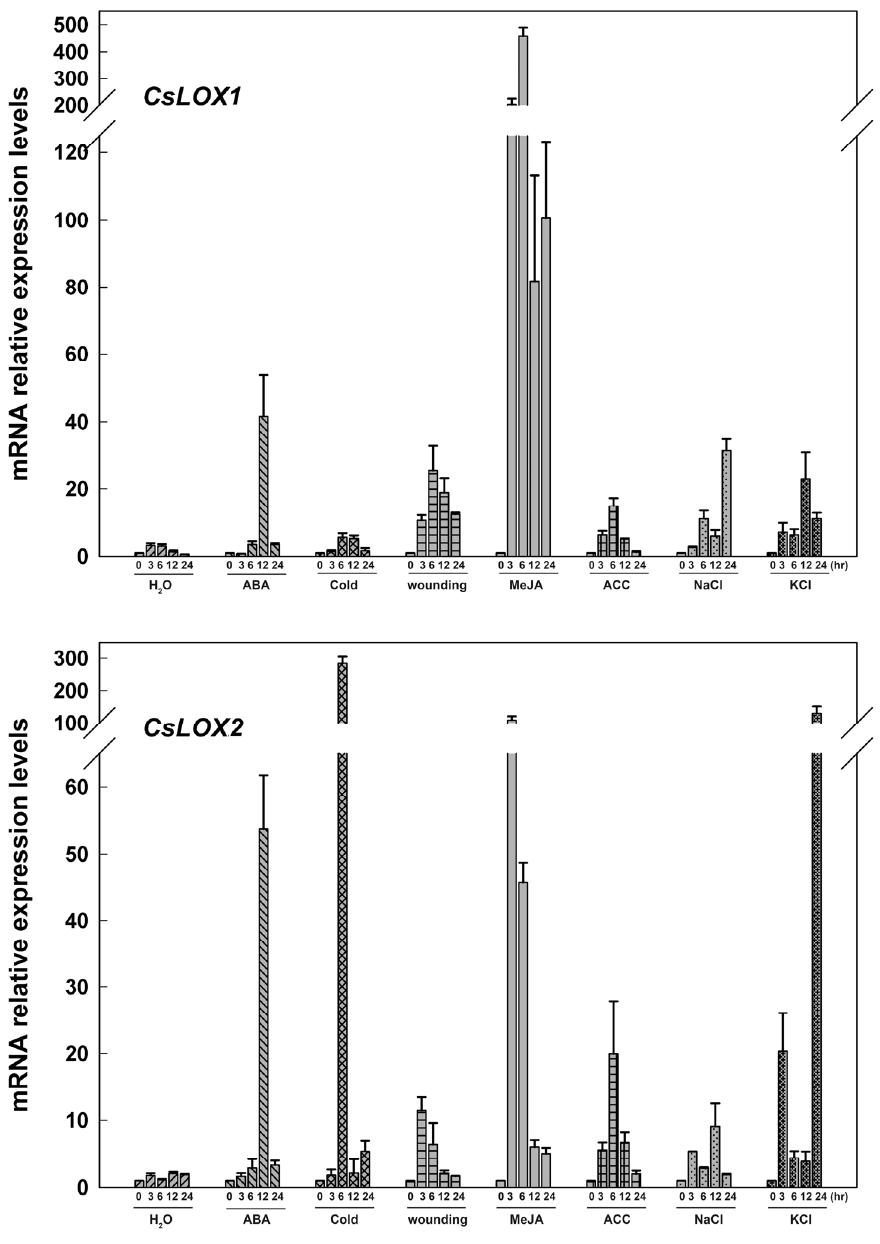
Figure 4. Expressions of CsLOX1 and CsLOX2 in cucumber leaves at various time points O, ABA (100 μ M), cold (4 °C), wounding, MeJA (100 μ M), ACC under treatments with H 2 (100 μ M) NaCl (200 mM) and KCl (200 mM) were analyzed by Real-time PCR. A cucumber actin gene CsACT (Csa017310) was detected as internal reference. Data represent the mean ± SD of three independent biological